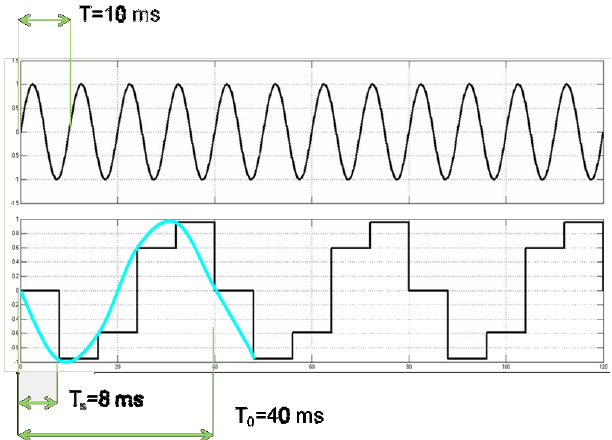
Fig. 6. Definition: T – period of signal; T s – sampling time; T 0 – period of recognized signal